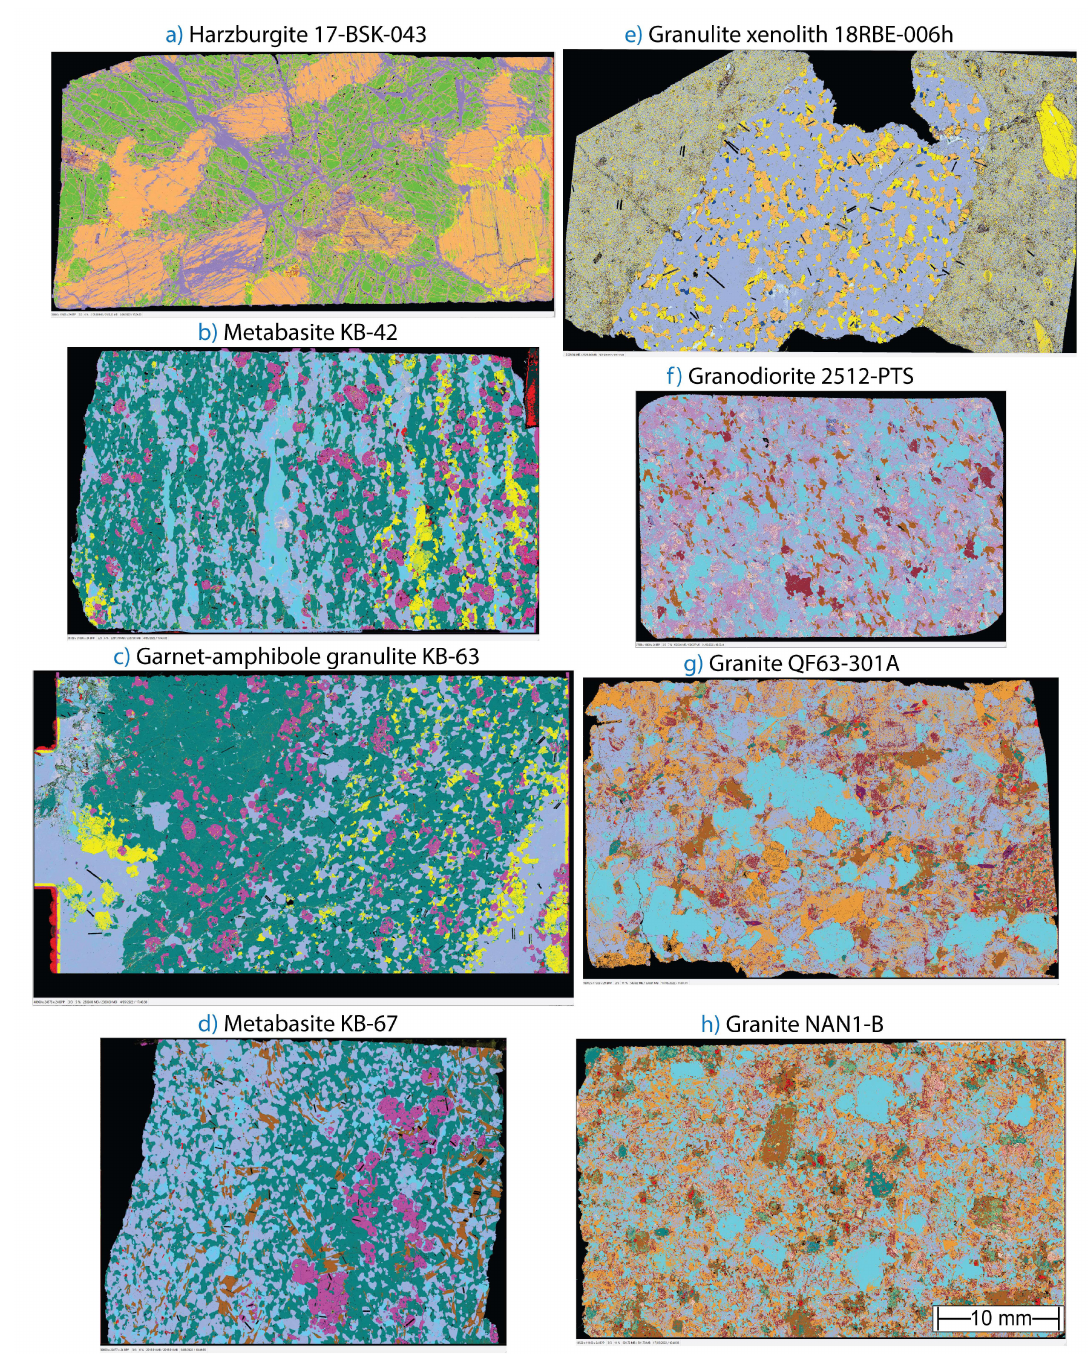
Figure 13. Optical phase maps of the image stacks (RL γ -boosted, PPL-max, and XPL-max). Visually, the fidelity is better in ultra-mafic and mafic rocks. It generally decreases towards felsic compositions due to pyroxenes and quartz-feldspar colour overlaps. The prediction scales of the maps (2 × 2 px: ( a – f ) maps, and 4 × 4 px: ( g , h ) maps) were set according to the visual quality assessment (iteration #1), see the colour legends in Figure 14. The published EDX phase maps are available for ( b – d ) in [24] and e in